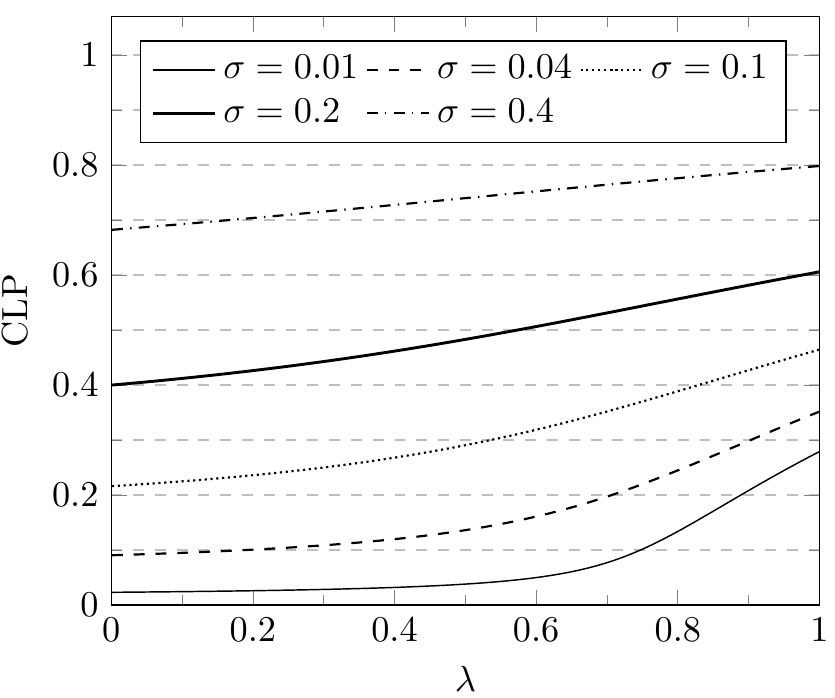
Figure 4. Customer loss probability CLP versus λ for Poisson arrivals, geometric service times with µ = 0.75 and different values of σ